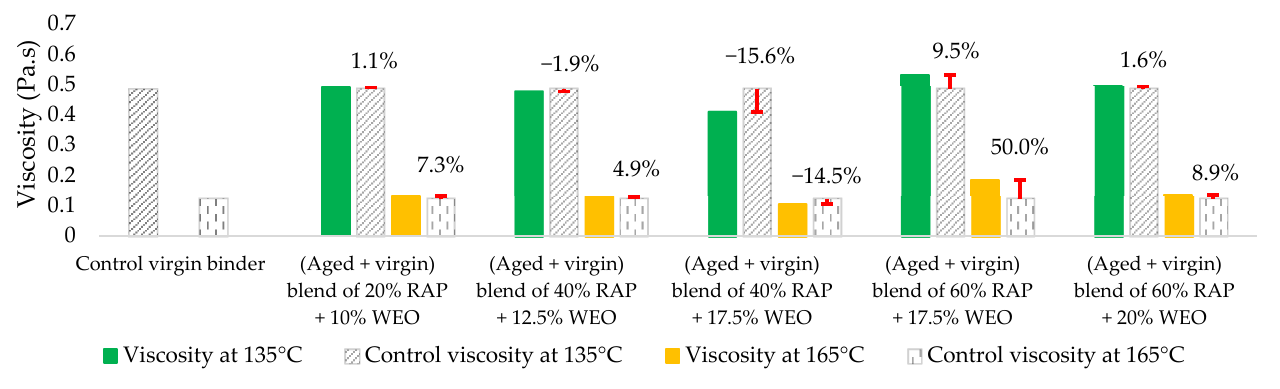
Figure 17. The change in viscosity level from adding WCO as a rejuvenator to the combined blend of binders in comparison to the control viscosity of the virgin binder.